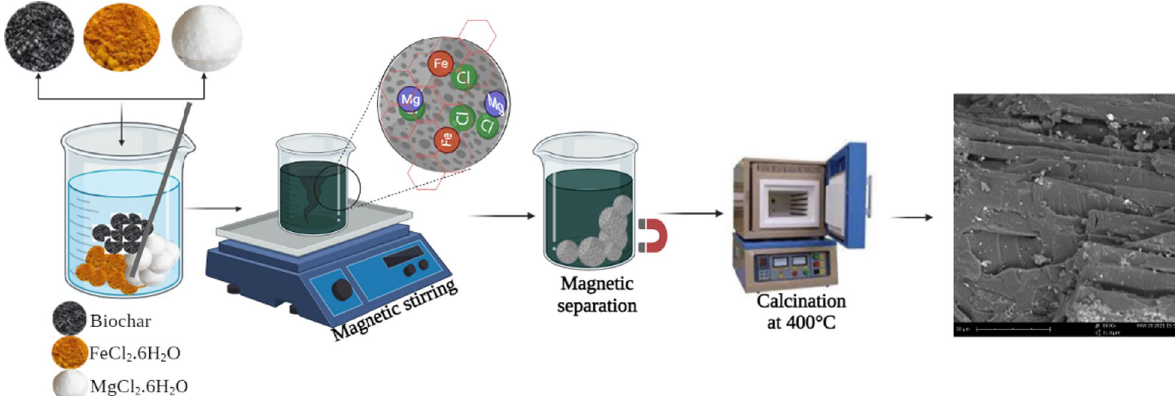
Fig. 1 Facile synthesis of MgO/Fe 3 O 4 CSB